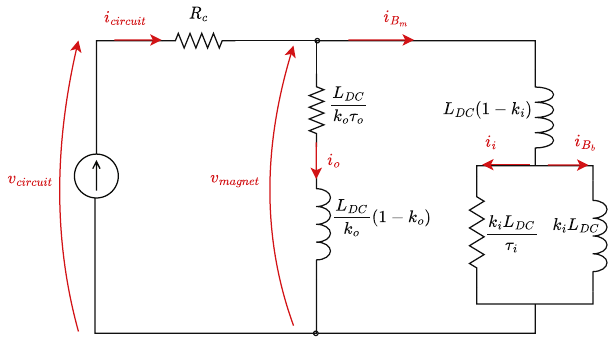
Figure 3: Full circuit model as seen from a power converter of a lossy superconducting magnet: inner and outer conducting shells. represents the resistance of the normal conducting cables R c connecting the power converter to the superconducting magnet.